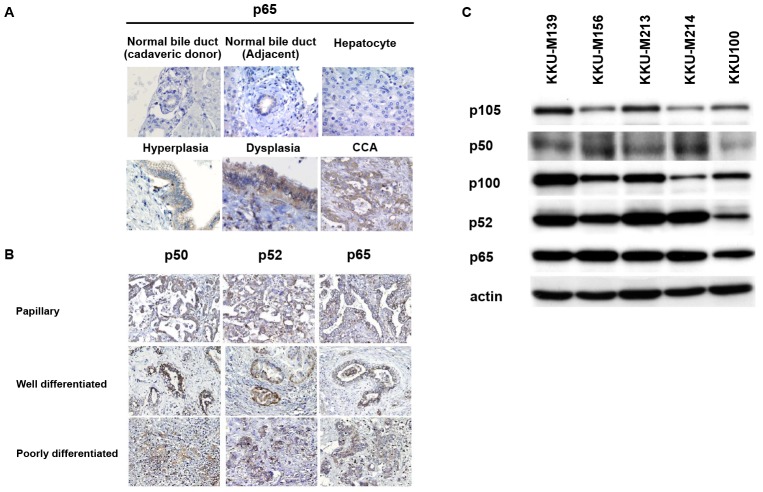
Expression of NF-κB in CCA patients and cell lines.The expressions of NF-κB in CCA tissues were determined by immunohistochemistry. A) Hepatocytes, as well as bile duct epithelia of normal liver tissues from cadaveric donor and of non-tumorous liver tissue from CCA patients showed weak immunoreactivity of NF-κB (p65). The expression of NF-κB, however, was gradually increased in hyperplasia, dysplasia and CCA. B) All NF-κB subunits, p50, p52 and p65, were overexpressed in different histological types of CCA tissues. Original magnification 20X, except normal bile duct, hepatocyte and dysplasia, 40X. C) Expression levels of NF-κB subunits, p50, p52 and p65, were determined in five CCA cell lines by western blotting. The precursors and active forms of NF-κB subunits, p105/p50, p100/p52 and p65, were strongly expressed in all CCA cell lines tested. Actin was used as an internal control.